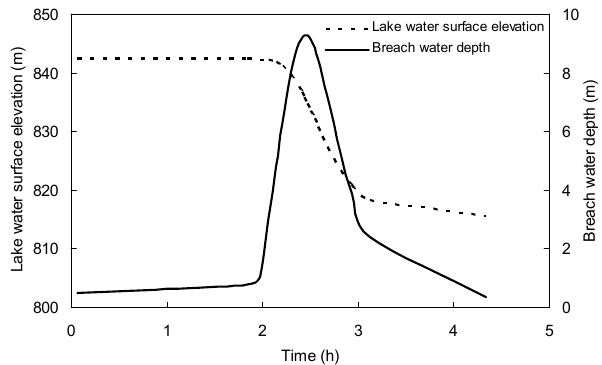
Fig. 14. Predicted lake water surface elevation and water depth within the breach during the erosion of the Xiaogangjian landslide dam.